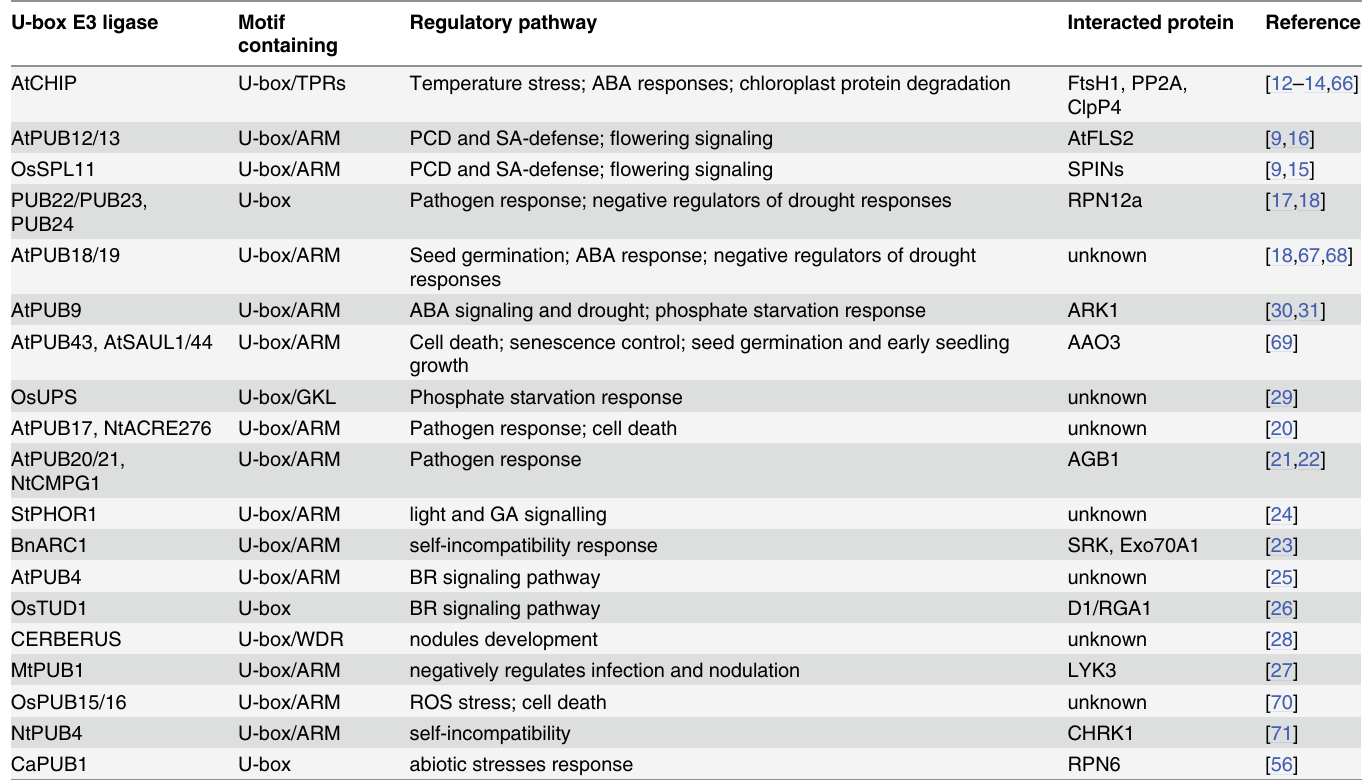
Table 1. Known PUB E3 ubiquitin ligases and targets of the Ub/26S proteasome pathway involved in plant growth and development. U-box E3